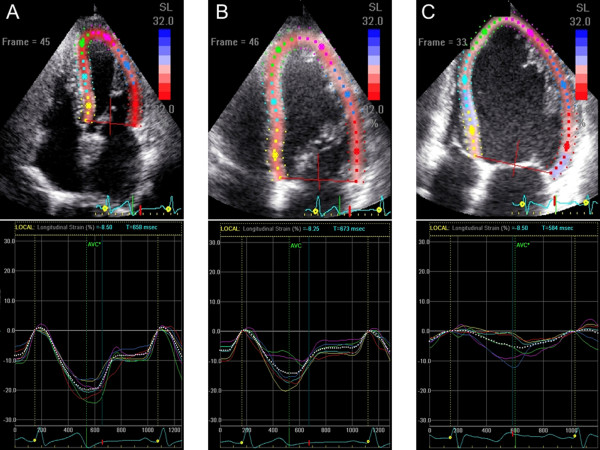
Examples of LV strain imaging in the apical four-chamber view (top) and corresponding time-strain curves (bottom) from a normal subject (A), a patient with OMI in the territory of left anterior descending artery and low plasma BNP level (B), and a patient with OMI in the all 3 coronary artery territories and high plasma BNP level (C).